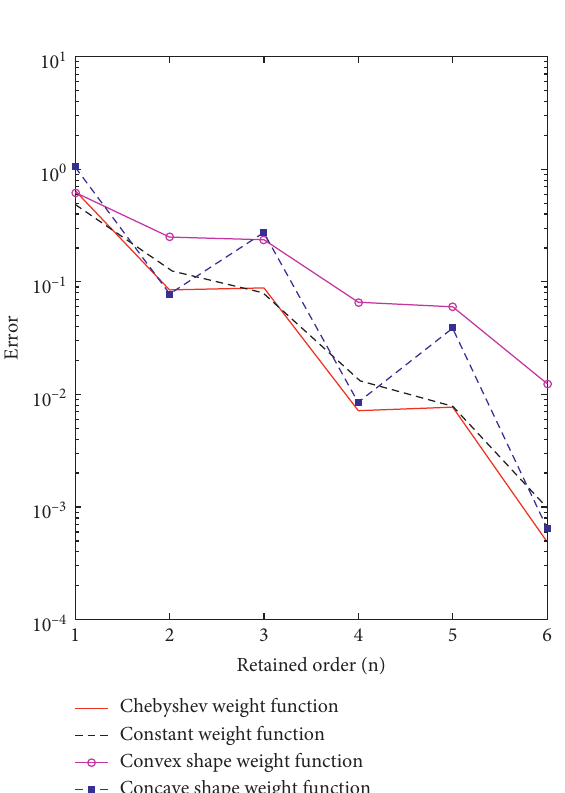
Figure 2: ε of moment-based arbitrary polynomial interval ex- ∞ pansion with different weight functions.